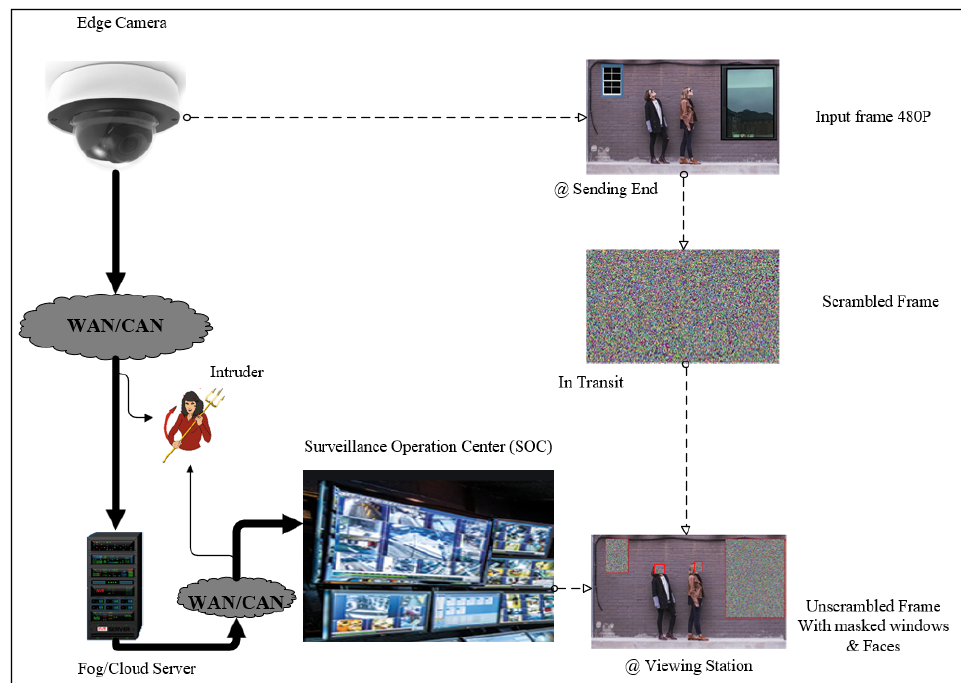
Figure 2. An illustration of the PriSE architecture: It comprises and edge camera that creates and encrypts frames, an intruder that tries to illegally access the video stream in transit, a cloud/fog server that deciphers frames, detects and masks windows and faces, and a viewing station where authorized people sits and observes activities caught on